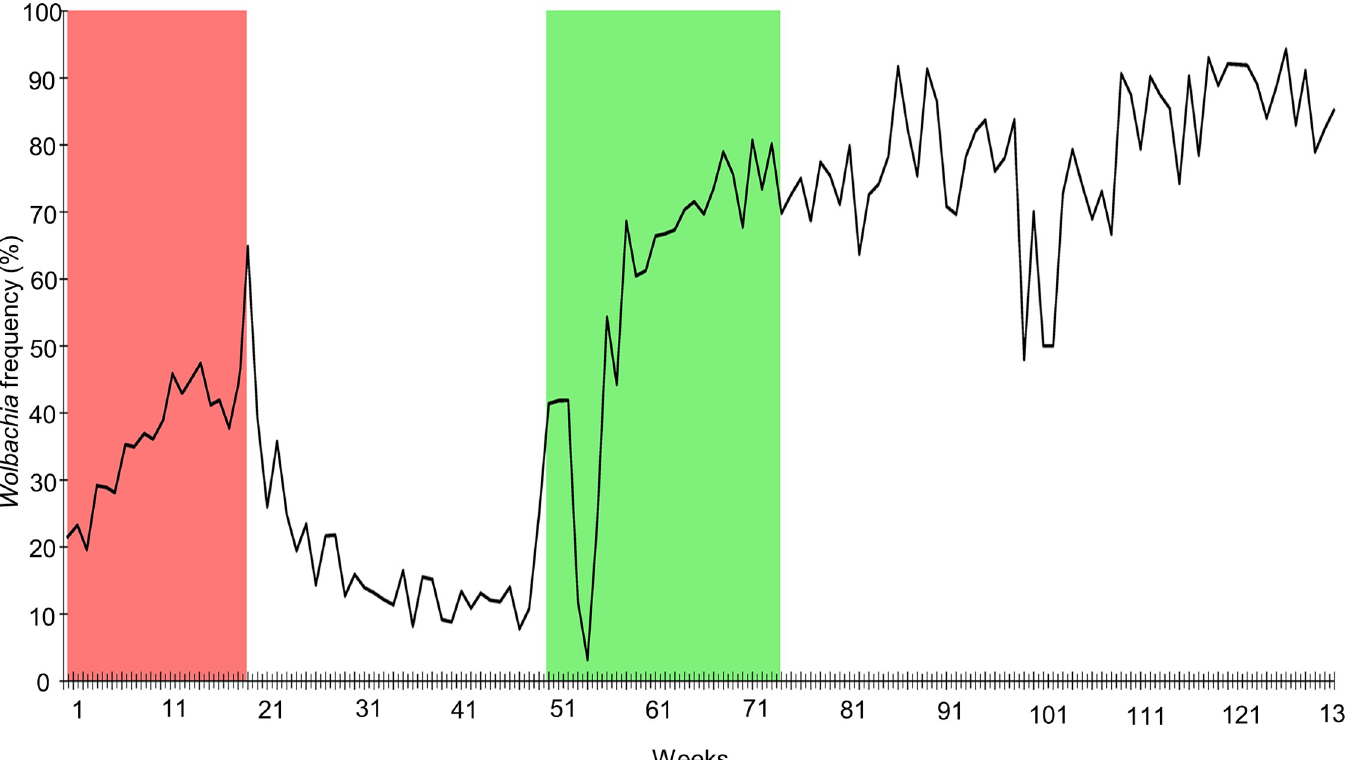
Fig 1. The frequency of w MelBr and w MelRio strains during Wolbachia deployment in Tubiacanga. Red area represents the w MelBr releases and Green area the w MelRio